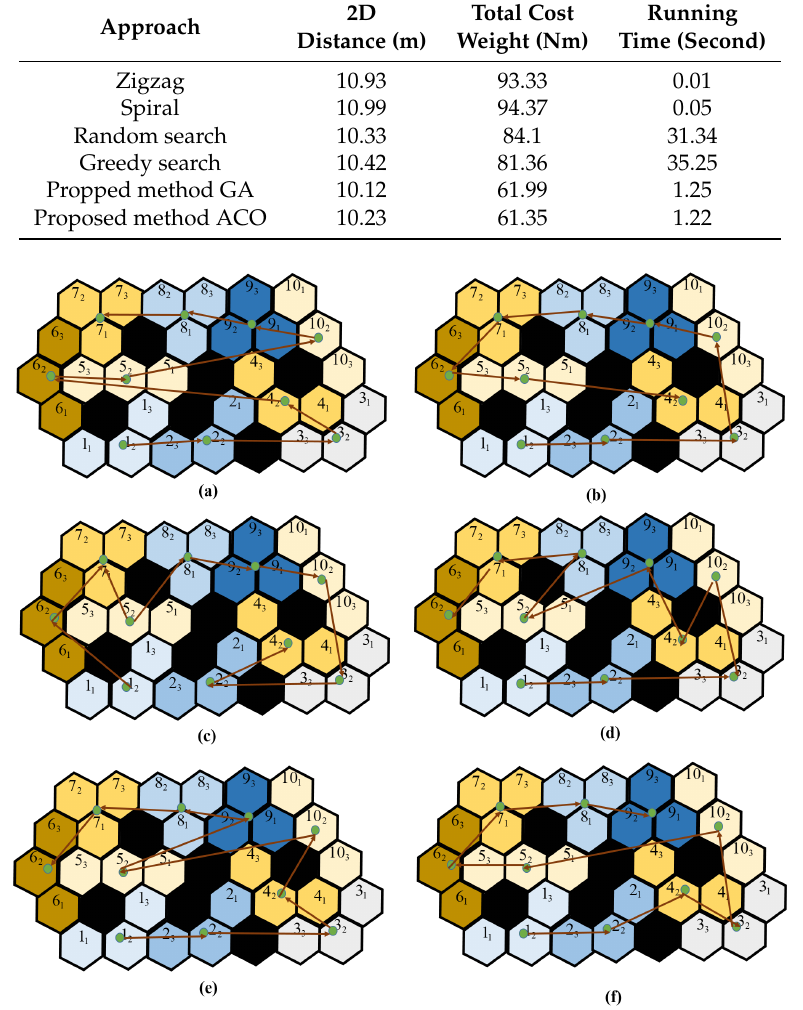
Figure 15. The trajectories comparisons of CACP approach: ( a ) zigzag scanning; ( b ) spiral scanning; ( c ) random search; ( d ) greedy search; ( e ) GA; and ( f )